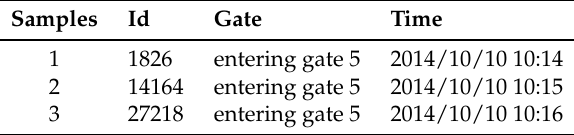
Table 5. Samples of the library open/close data.